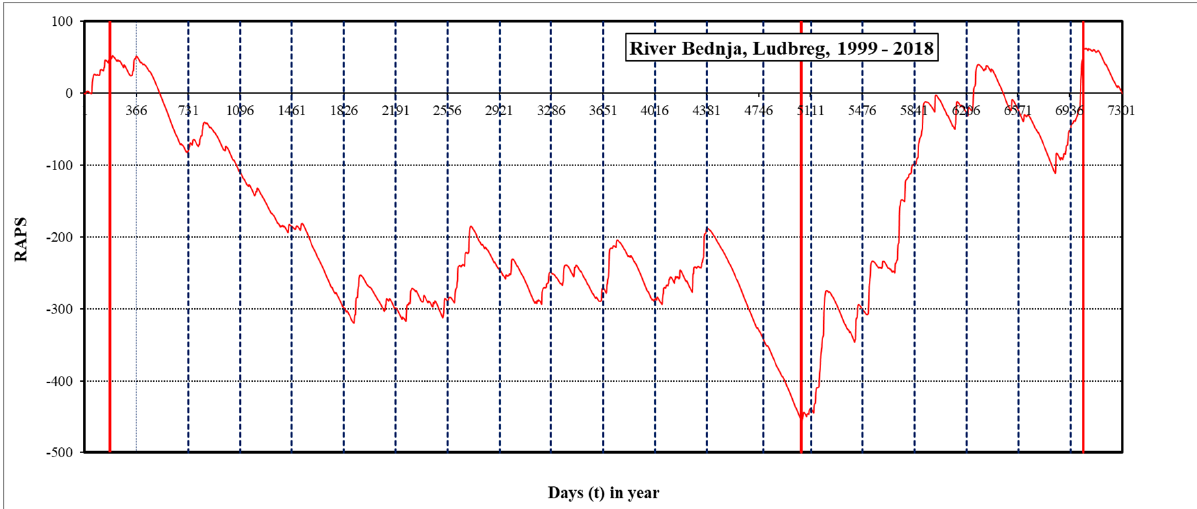
Figure 3. RAPS diagram for the river Bednja.